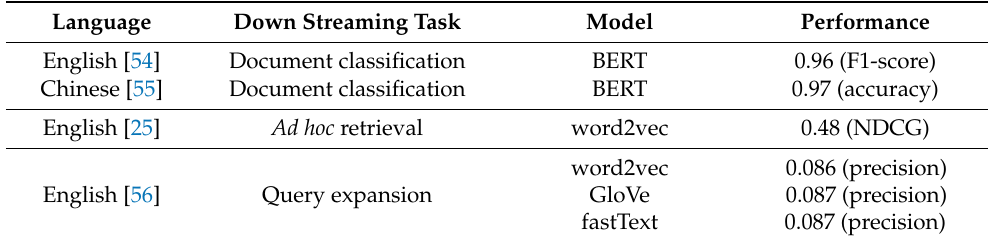
Table 13. Performance of word embeddings and BERT models on some tasks on some